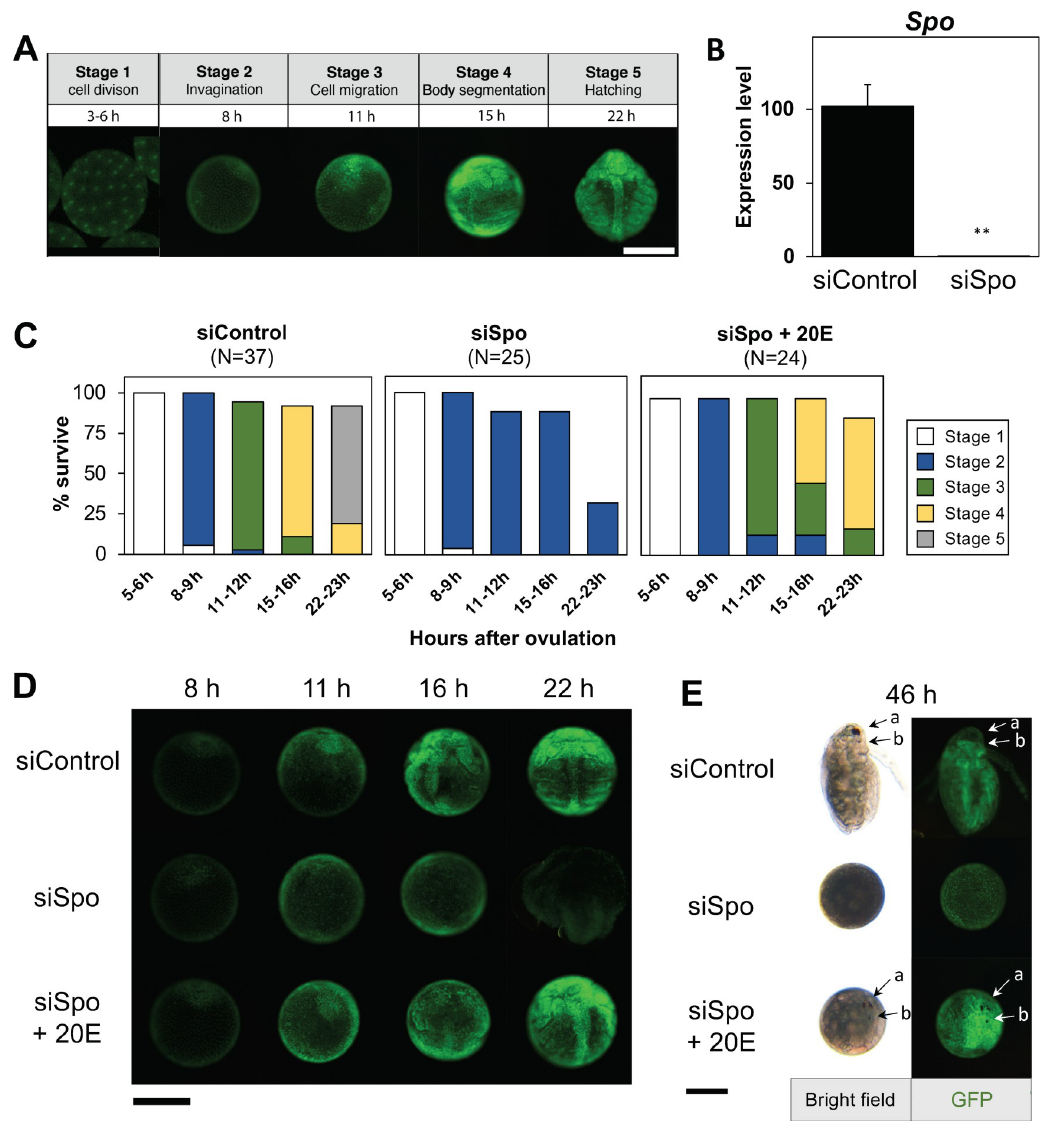
Fig 2. Spo is essential during early embryogenesis in Daphnia magna . (A) Developmental stages of D . mag na during early embryogenesis at 23˚C as observed by GFP fluorescence in an H2B-GFP transgenic line. (B) Expression levels of Spo in siControl and siSpo embryos at 6 h assessed by qRT-PCR. Values are means. Error bars represent SD (N = 3). �� p < 0.01 (Student’s t -test). (C) Developmental progression and survival rate of siControl and siSpo with or without exposure to 1 μ M 20-hydroxyecdysone (20E). Bars denote the developmental stages described in (A): stage 1 (white), stage 2 (blue), stage 3 (green), stage 4 (yellow), stage 5 (gray). (D) Representative images of embryos injected with siControl, siSpo, and siSpo rescued by 20E. Embryos were imaged by GFP fluorescence. Representative photographs from different stages are combined into a single image. (E) Retardation of embryo developmental progression. Compound eye (a) and naupliar eye (b) development observed at 46 h after ovulation. Scale bar, 200 μ